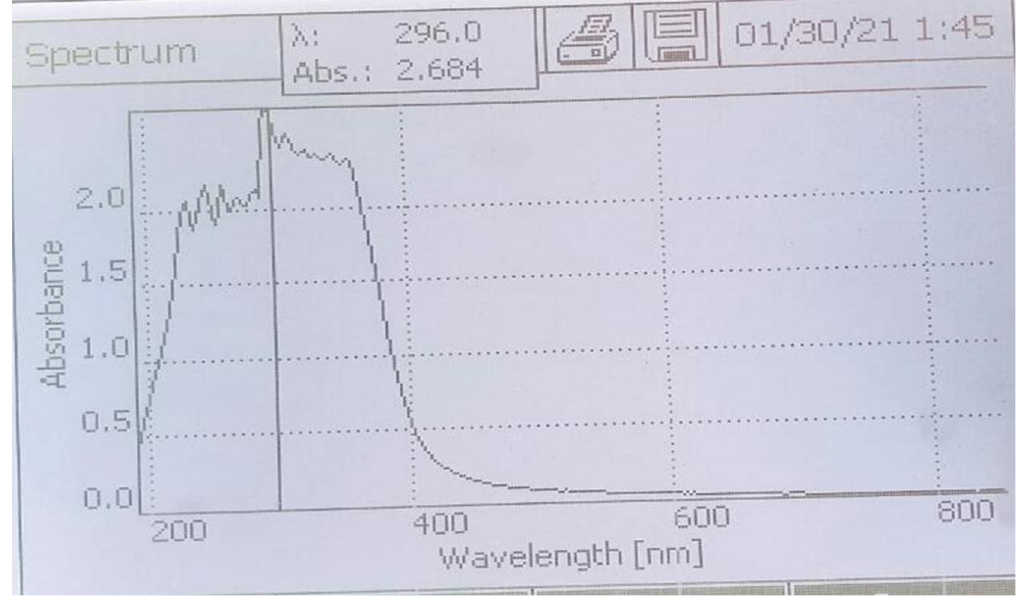
Figure 9. Ultraviolet-visible spectral analysis of synthesized ZnO NPs using A. indica leaf extract.